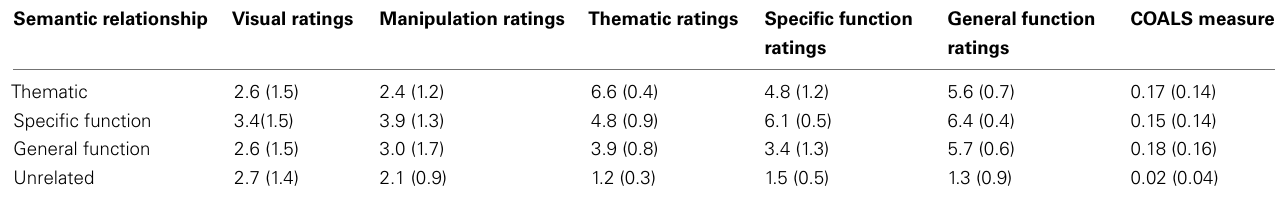
Table 2 | Mean values and standard deviations of normative ratings and COALS measures for the thematic, specific function, and general function related and unrelated object